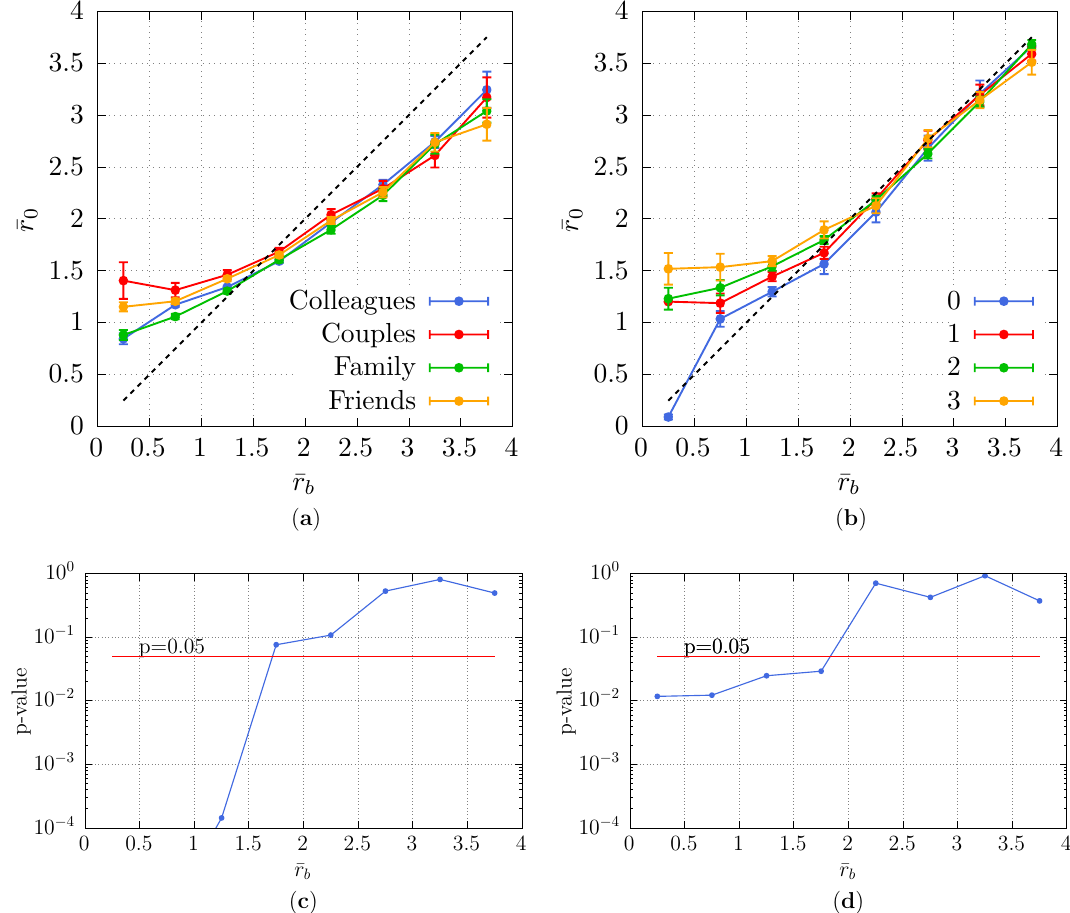
Figure 5. Observed minimum distance ¯ r 0 as a function of the undisturbed straight-line distance ¯ r b ( a ) for various social relations and ( b ) intensities of interaction of the group. Error bars report standard error intervals. The dashed line corresponds to the ¯ r 0 = ¯ r b linear dependence. p -values for the ANOVA of ¯ r 0 ( c ) for various social relations and (d) intensities of interaction of the dyad. In ( c ), results for ¯ r b < 1 are not displayed as very − 6 low values were obtained ( p < 10